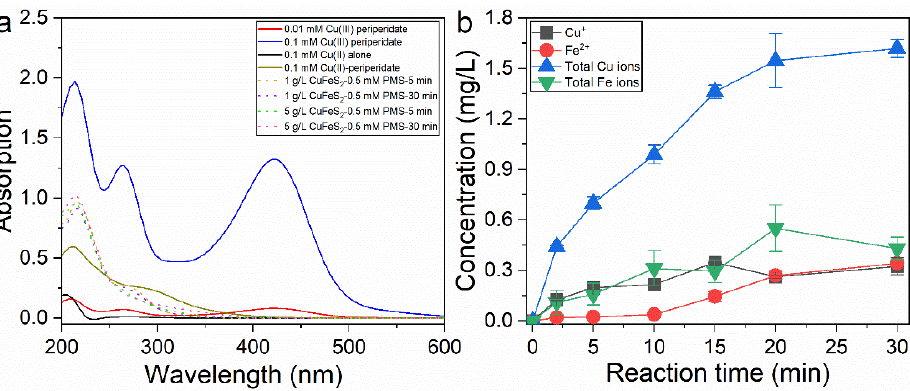
Figure 4. ( a ) UV–Vis adsorption spectra of different reaction systems; ( b ) concentrations of dissolved